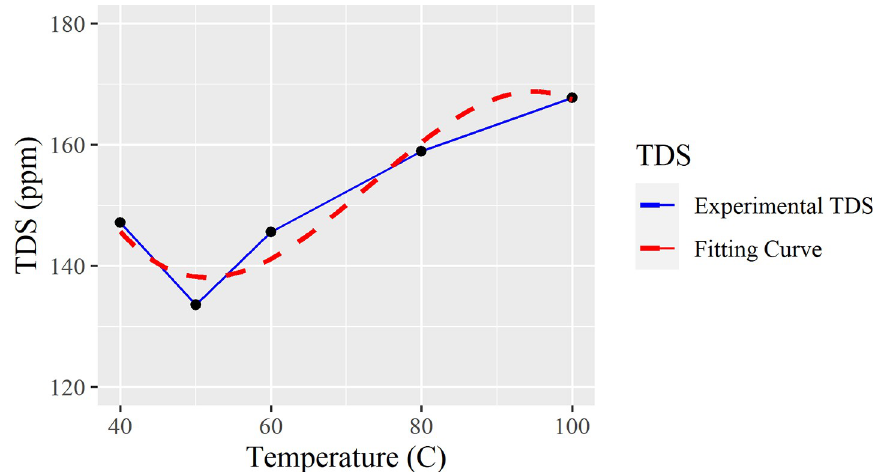
Fig 3. Fitting curve of TDS changes over all temperatures between 40–100˚C.